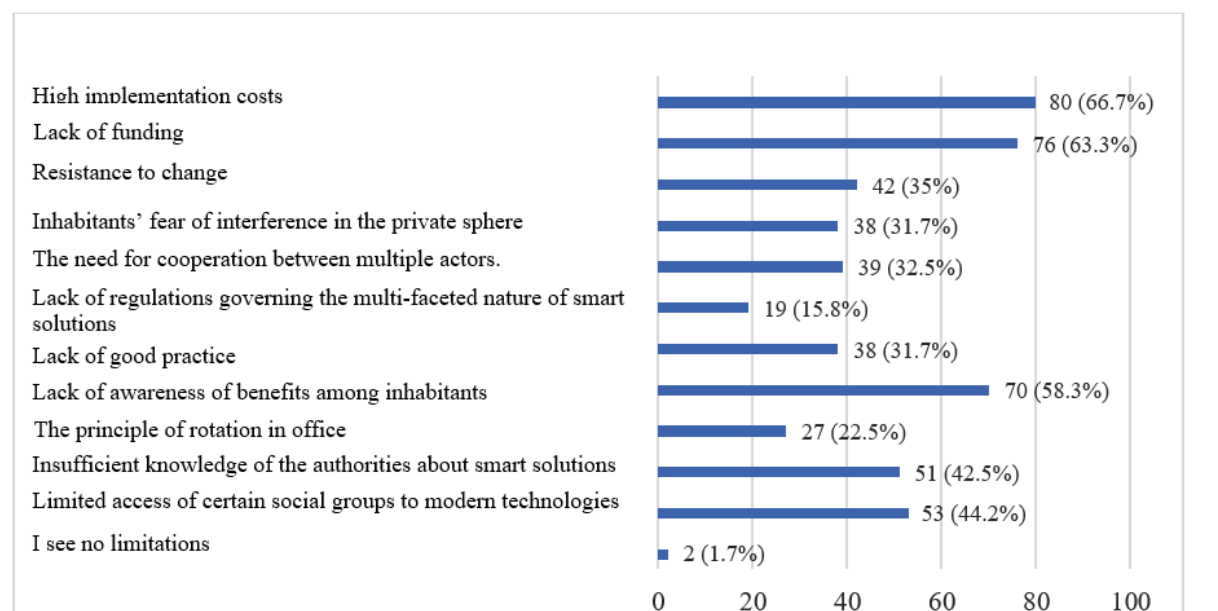
Figure 17. Obstacles encountered in implementing a smart city project according to respondents. Source: own study based on questionnaire survey.